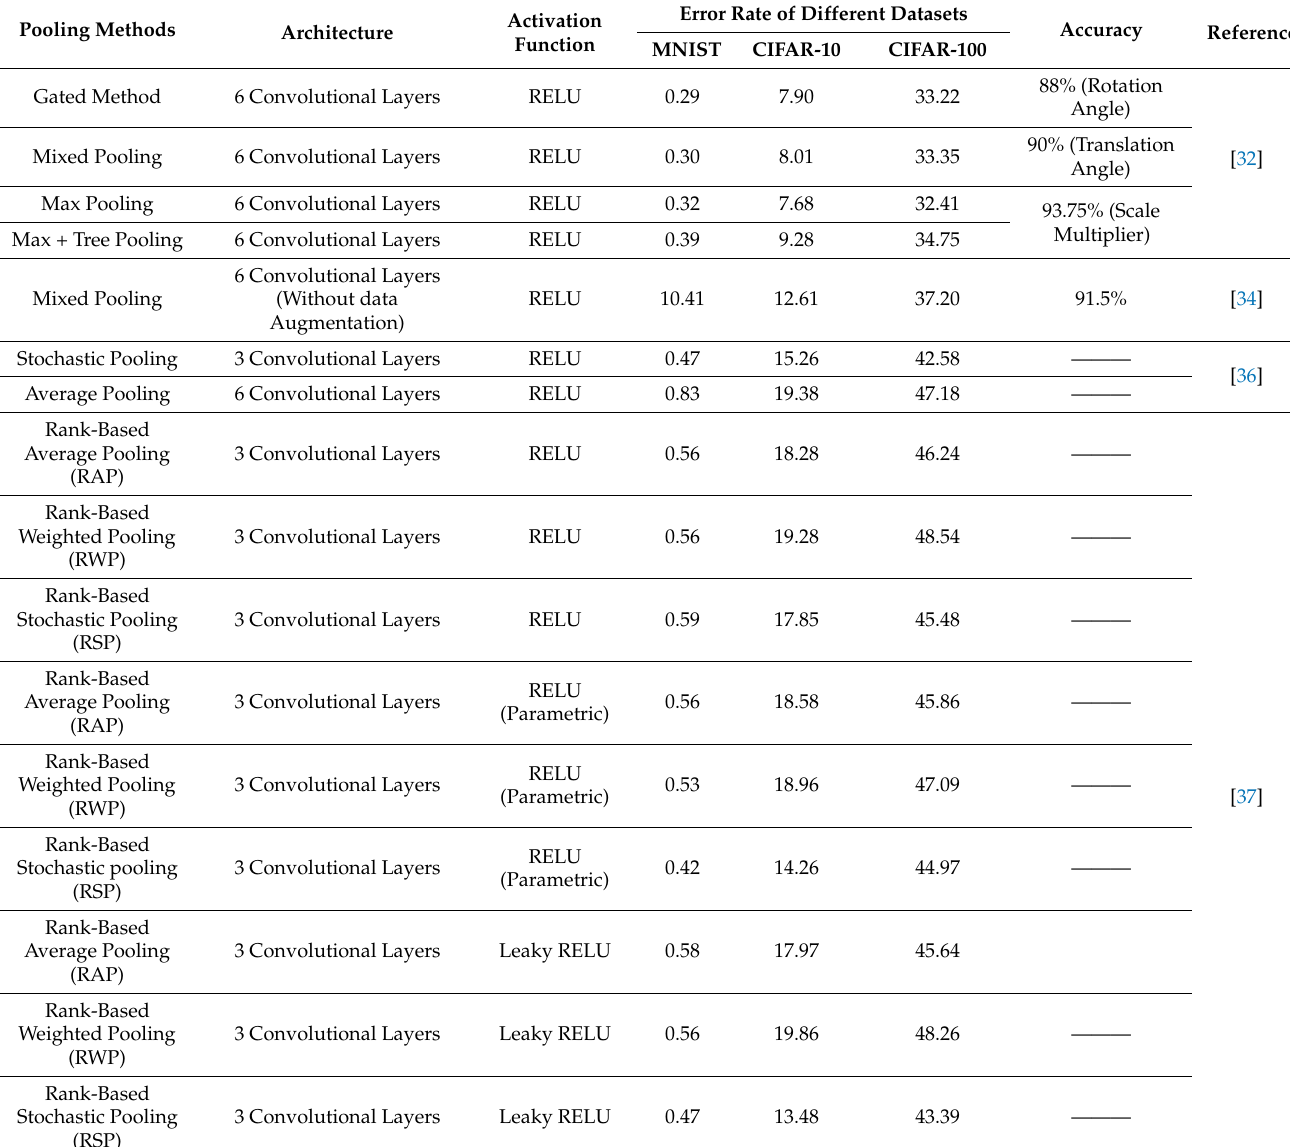
Table 2. Comparing performance of various pooling methods on different standard